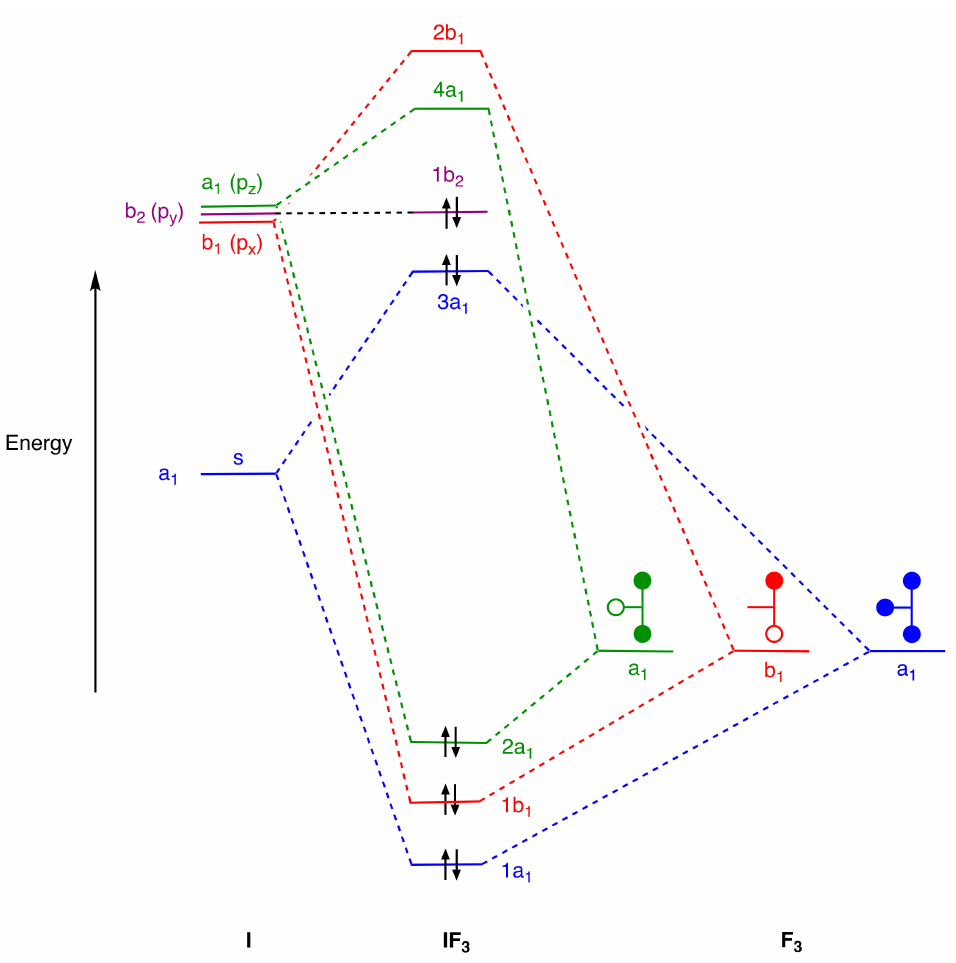
Figure 5. A simple, qualitative, σ -only MO energy-level diagram for IF 3 . Orbital interactions involving iodine 5s (a 1 ), 5p z (a 1 ), and 5p x (b 1 ) orbitals are shown in blue, green, and red, respectively. Orbital 1b 2 (iodine 5p y ) shown in purple is non-bonding by symmetry. Orbital 3a 1 is the antibonding counterpart to the 1a 1 bonding